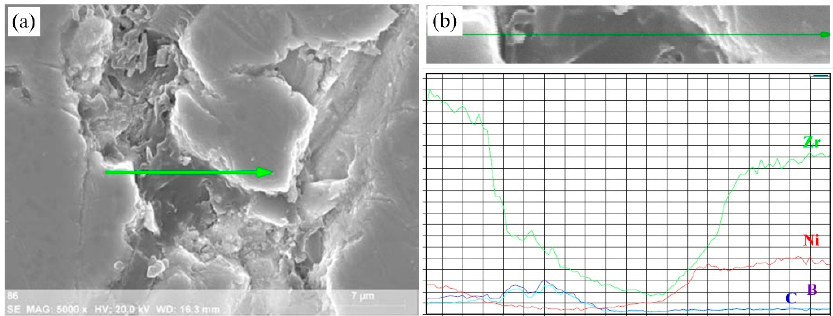
Figure 13. Microstructure of a remnant B 4 C particle dissolving into the Ni–Zr–B–C melt and the corresponding EDS-line analysis in the combustion region: (a) SEM image and (b) EDS-line analysis.